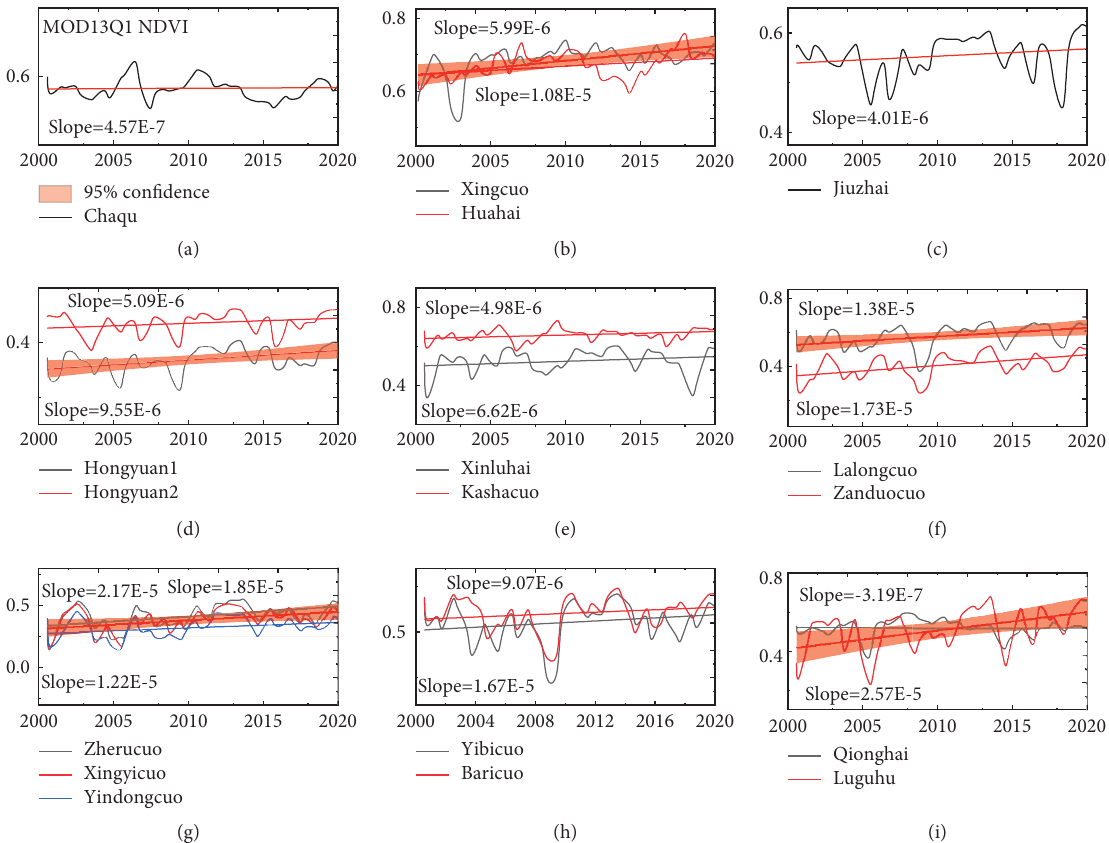
Figure 6: Vegetation change trend of the lake wetland on a site scale (2000–2020). Latitude of the lake site gradually decreased from subfigure (a) to (i). Elevation of sites (a), (d), (g), (f), and (h) are above 4500m, elevation of sites (b), (c), and (e) is about 3000–3900m, and elevation of site (i) is less than